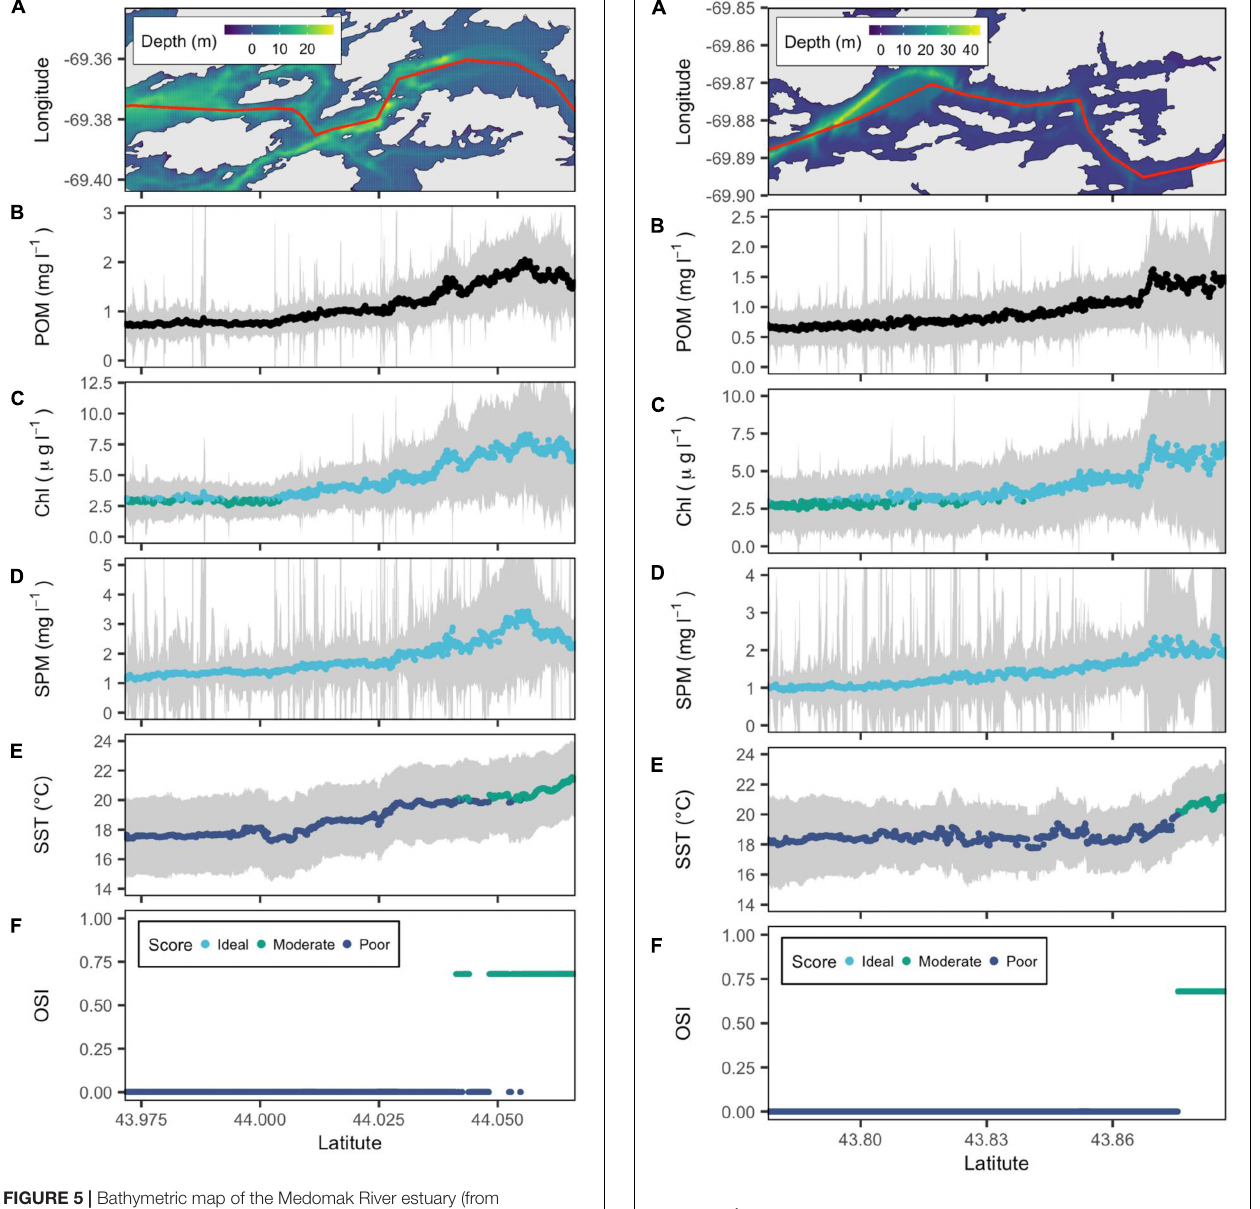
FIGURE 6 | Bathymetric map of the New Meadows River estuary (from downstream to upstream left to right) with a red line showing the central transect. (A) POM (B) , SPM (C) , Chl a (D) , and SST (E) are reconstructed from remote sensing data, and OSI (F) is derived following the method of Snyder et al. (2017). Gray color belts show standard deviation of POM, SPM, Chl a, and SST derived in summer (June–September) over the period 2016–2020, with their median values depicted by blue, green, and cyan points that denote poor, moderate and ideal conditions for oyster aquaculture,